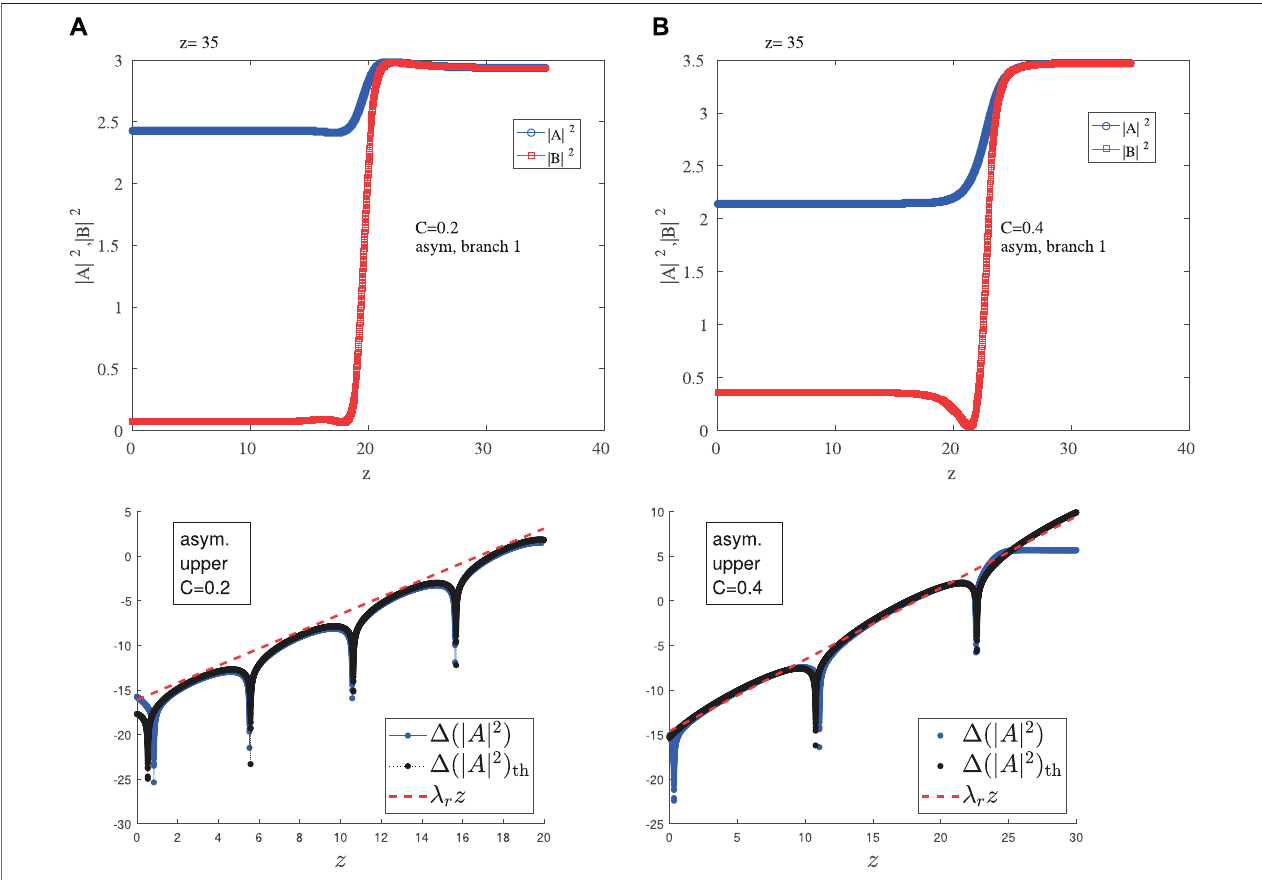
FIGURE 9 | Evolution of steady state solutions from the asymmetric upper branch (A) C = 0.2 (B) C = 0.4. The amplitudes of the top panel evolve towards the symmetric values of the upper symmetric (stable) branch in the top panels. The bottom panels show the growth process in semilog scale corroborating not only the real part involving the growth (dashed red line), but also the imaginary part associated with the oscillation (cf. the theoretical curve in black vs. the numerical results in blue).